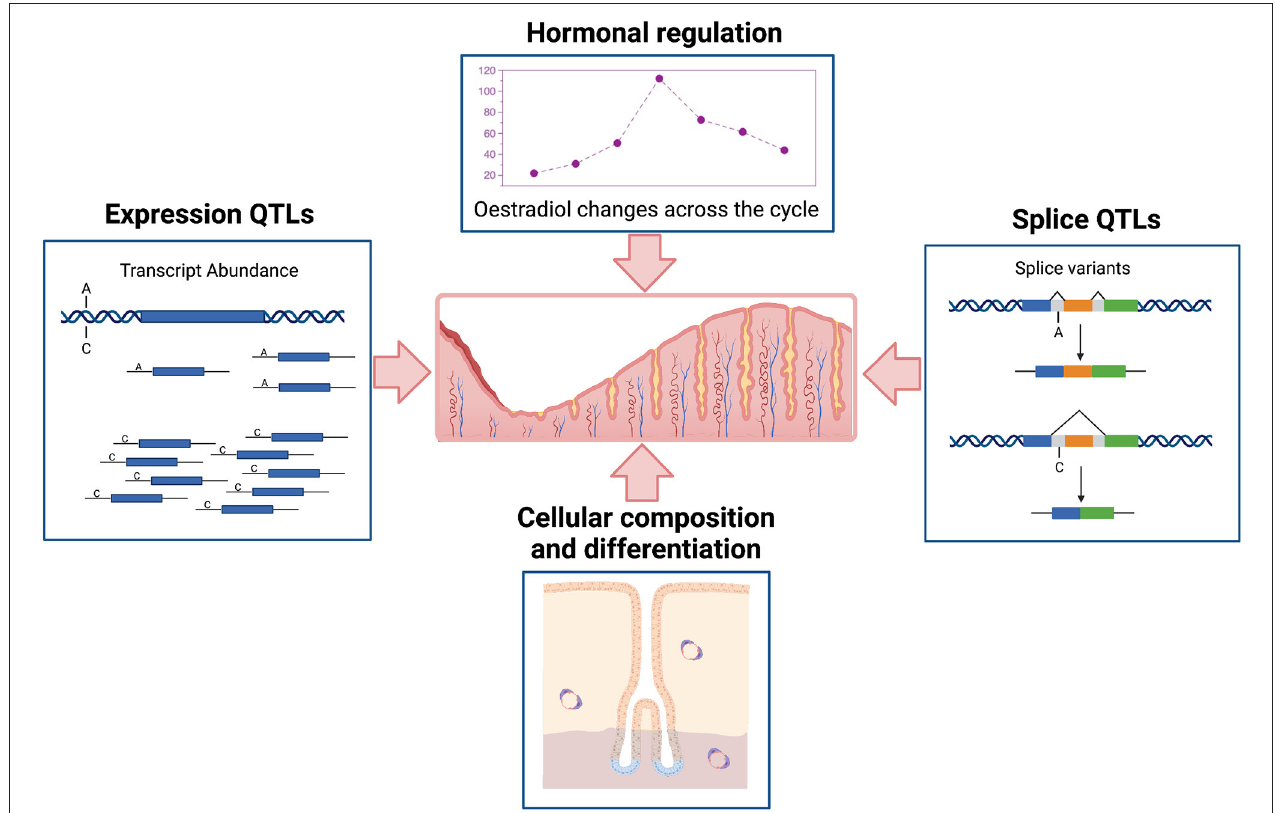
FIGURE 1 | Schematic representation of major factors affecting variation in transcription in human endometrium. Created with